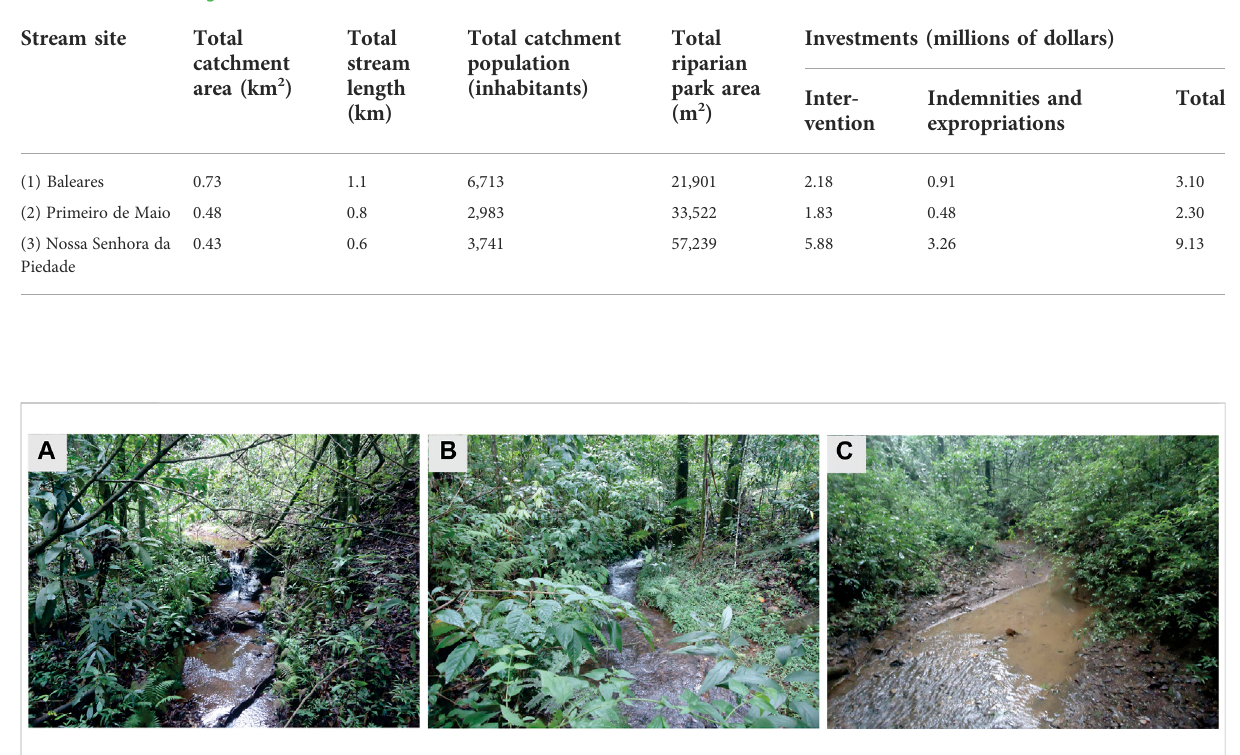
TABLE 1 Budgets for the rehabilitation of Baleares, Primeiro de Maio, and Nossa Senhora da Piedade streams between 2006 and 2008 (from BID, 2008; Macedo and Magalhães Jr.